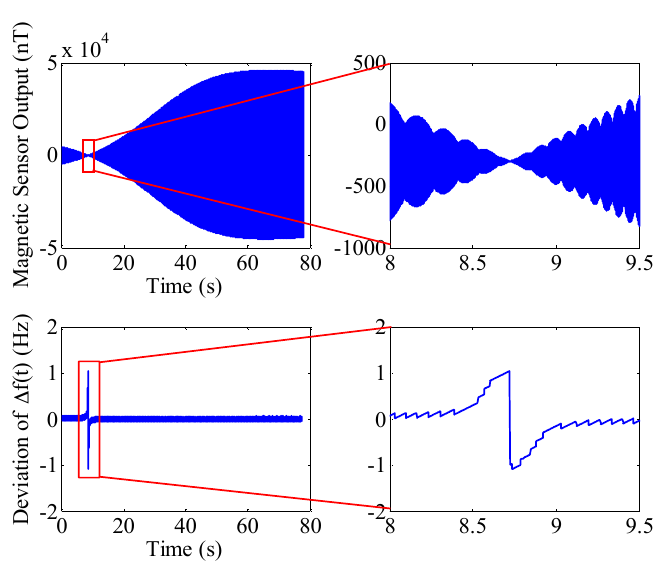
Figure 17. Radial MR sensor output and the spin rate deviation with a launch aspect angle of 175.45°. The top right figure is a local enlarged drawing of the radial MR sensor output. The bottom right figure is a local enlarged drawing of the spin rate deviation with a launch aspect angle of 175.45°.